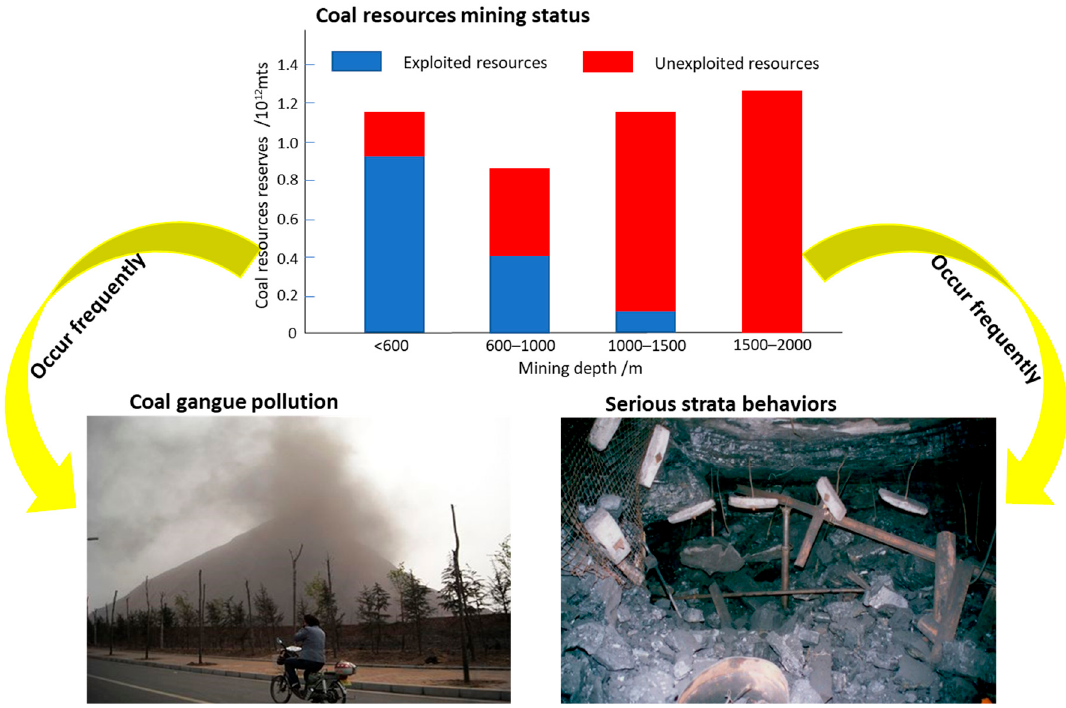
Figure 1. Urgent problems of coal resources.